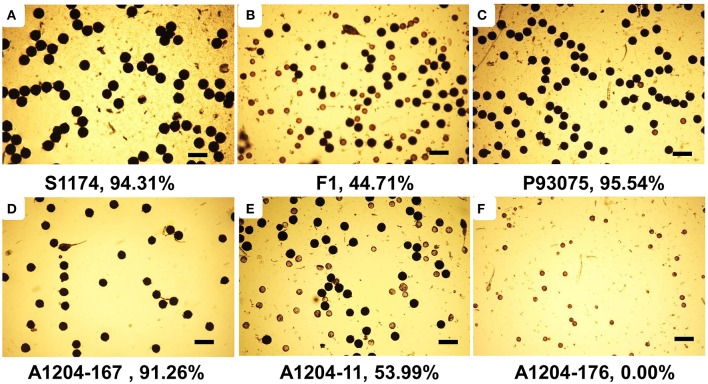
Pollen phenotypes of S1174 (A), P93075 (C), F1 (B), and F2 plants (D–F). Three male flowers with three fields of vision were analyzed and the fertile pollen rate in each field was calculated, taking their average value as the fertile pollen rate of single plant. Bars = 200 μm.